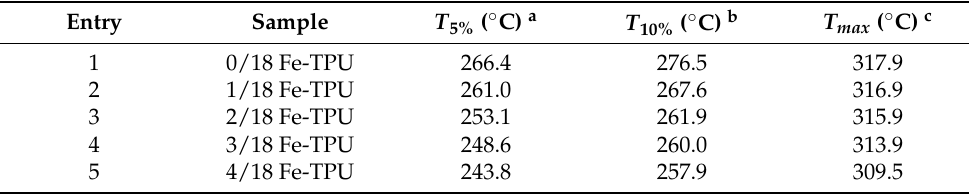
with different DMBA contents, Figure S4: DSC curves of TPU reinforced with FeCl3, Table S1: Data summary of PPCD, Table S2: DSC data of TPU reinforced with FeCl 3 .